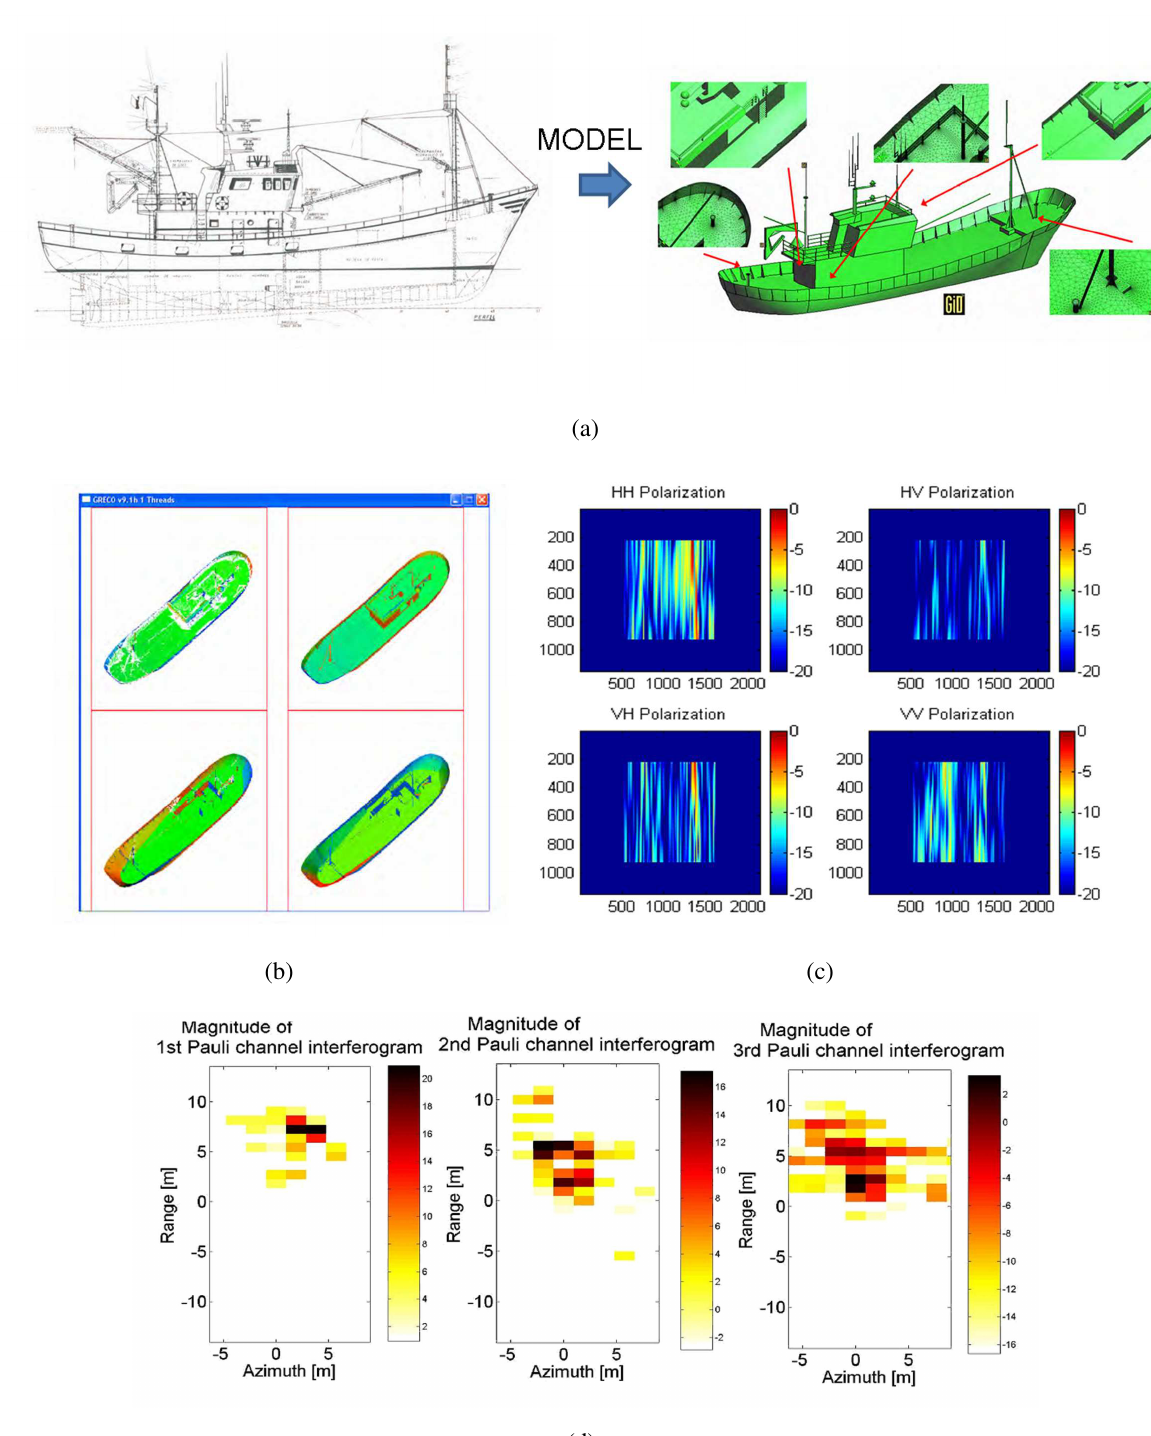
Figure 3. Series of snapshots providing a graphical guide of the main steps followed by GRECOSAR: 1) Snapshot of the blueprint of a vessel (a left) and the resulting meshed CAD model (a right), 2) snapshot of the bitmap generated by GRECO (b), 3) snapshot of the magnitude of the synthesized raw data (c) and final POLInSAR dataset (d). For GRECO bitmap, the colors indicate the sense of the normal vector of each surface according to the RGB code with red pointing to horizontal, green to the observer and blue to the